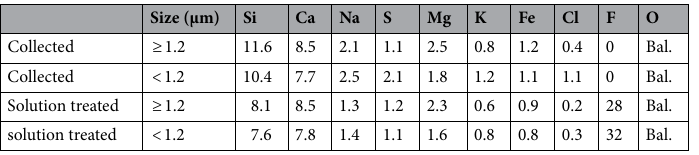
Table 1. Elemental constitute of dust particles (wt%). It is worth to mention that average size of dust particles is 1.2 µm.